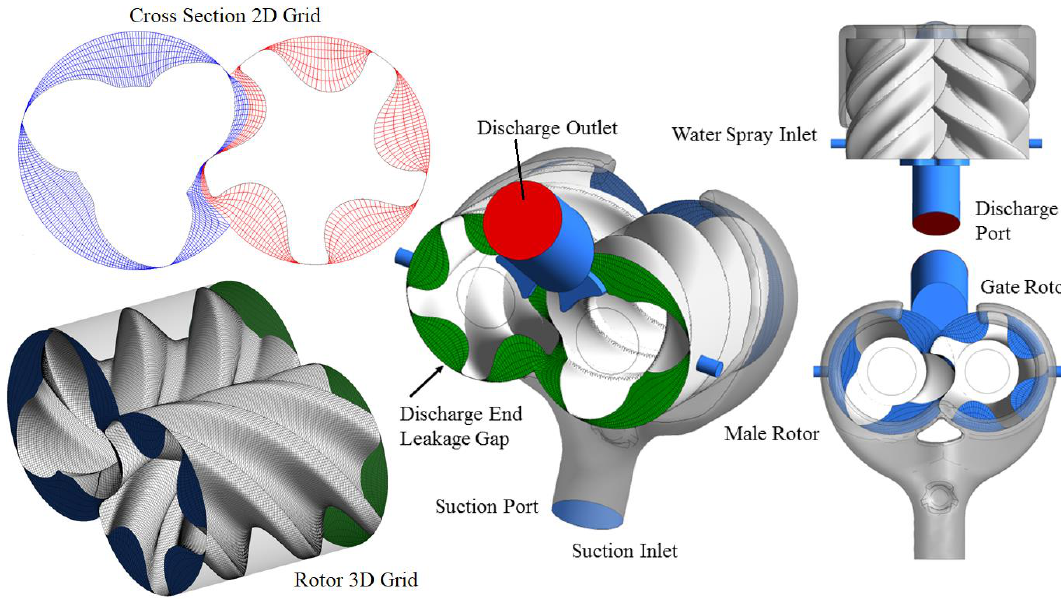
Figure 7. Flow domain and rotor grid of a water-injected twin screw compressor [23].